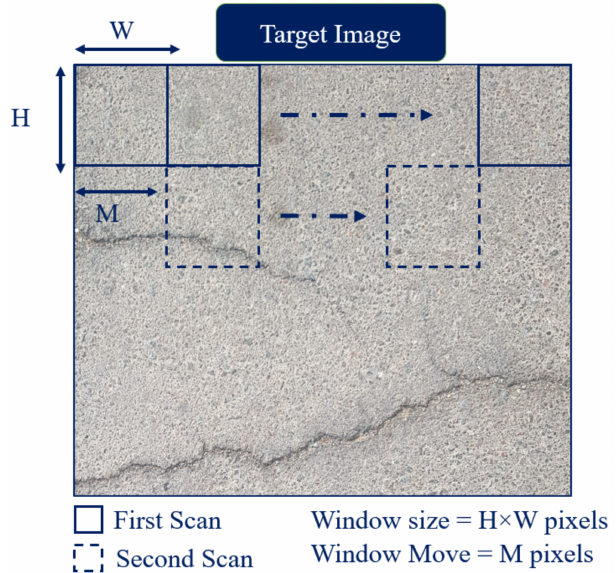
Figure 4. Representation of sliding-window